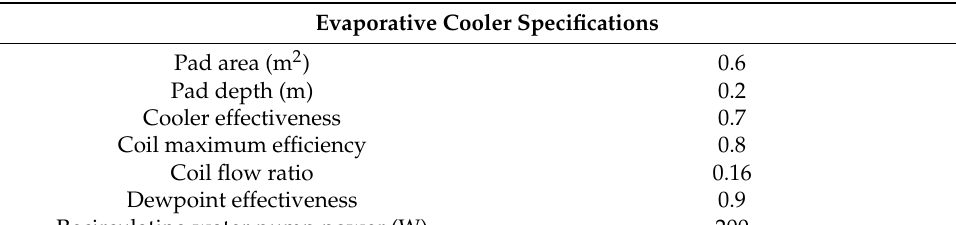
Table 2. Evaporative cooler specifications used.